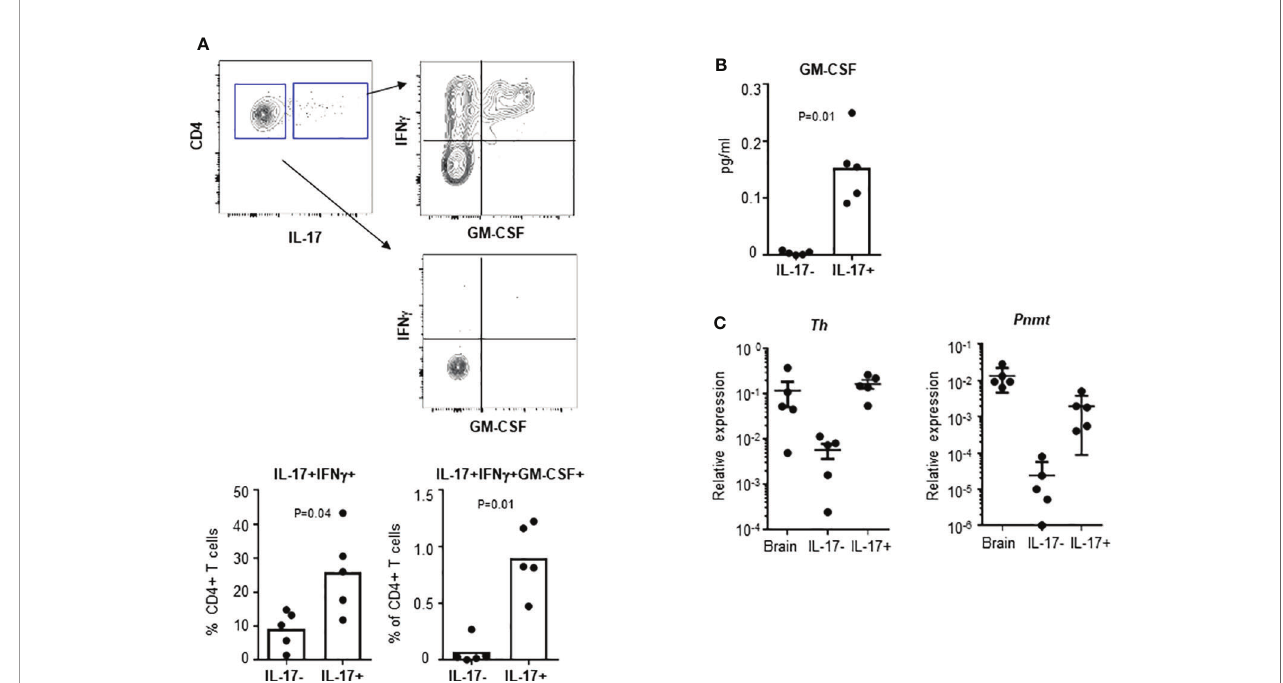
FIGURE 4 | Th and Pnmt expression in pathogenic T H 17 cells. (A) T H 17 and non-T H 17 cells were identi fi ed by IL-17 production and co-stained with IFN g and GM- CSF in EAE induced animals. IFN g - or IFN g /GM-CSF-expressing pathogenic T H 17 cells were quanti fi ed. IL-17+ T H 17 and IL-17- non-T H 17 cells were isolated and cultured overnight for GM-CSF in the supernatant (B) . Or the isolated cells were directly used for RNA isolation and Th and Pnmt was measured by qPCR (C). Each dot represents an individual animal and the bar represent the mean (n =